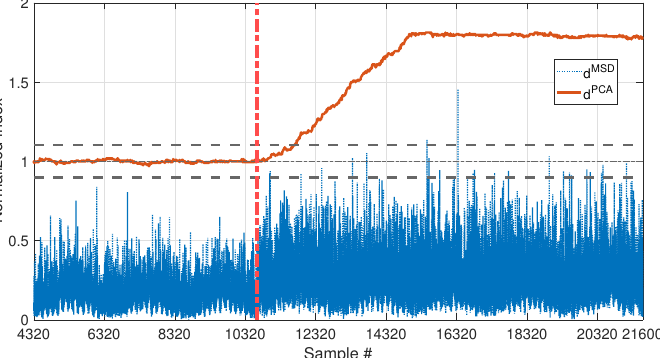
Figure 14. Comparison between d MSD (blue dotted line) and d PCA (red solid line), with b = 4320, con- sidering long and short-term temperature trends and damage (10% reduction of Young’s modulus).